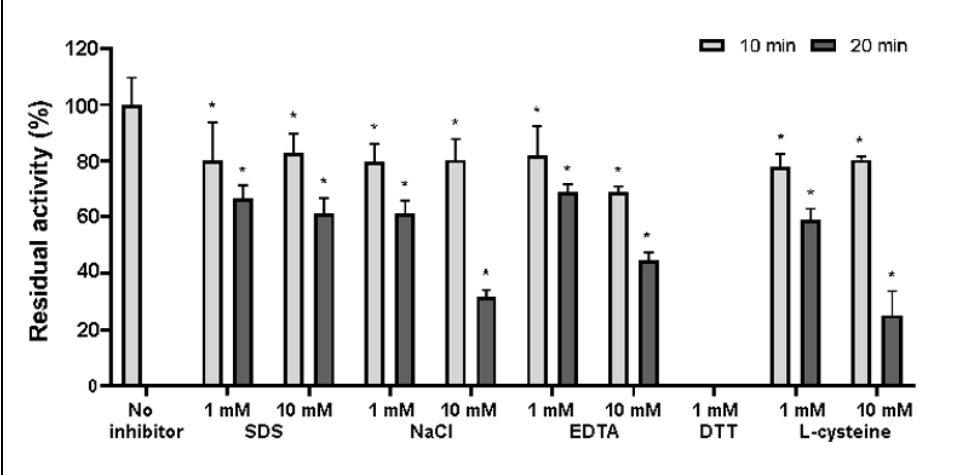
Figure 2. E ff ect of di ff erent inhibitors on FNTL activity. SDS, NaCl, EDTA, DTT, and L-cysteine were Figure 2. Effect of different inhibitors on FNTL activity. SDS, NaCl, EDTA, DTT, and L-cysteine were tested at concentrations of 1 and 10 mM. Recombinant laccase activity was measured after 10 and 20 min of incubation with each inhibitor. Each bar represents the mean of three independent measure- ments. The significant differences were determined using one-way ANOVA, followed by multiple comparisons between the treatments and control using Dunnett’s test, indicated as * = p < 0.05. The obtained results indicate that this enzyme maintained at least 70% of its activity after 10 min of incubation with all the different inhibitors tested at both concentrations, with the exception of DTT, which completely inhibited the enzyme. After 20 min of incubation, FNTL maintains more than 60% of its activity with 1 mM and 10 mM SDS, 1 mM NaCl. This is consistent with our previous results that indicate that, after 1 h incubation, the enzyme retained 67% and 50% of its activity with 1 mM of SDS and NaCl, respectively